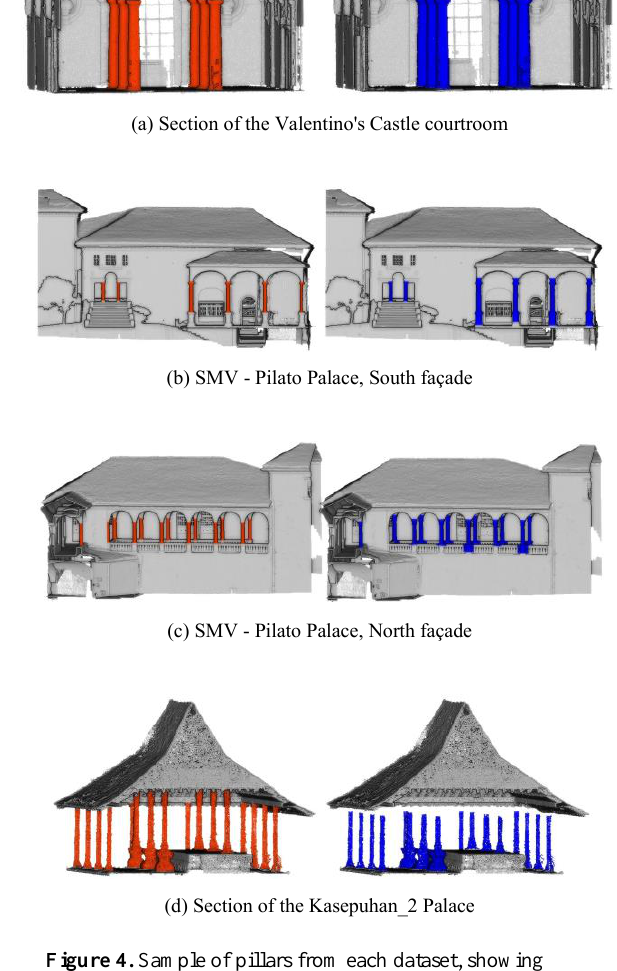
Figure 4. Sample of pillars from each dataset, showing results of manual labelling as reference (red, left-hand side) and those from M_HERACLES (blue, right hand